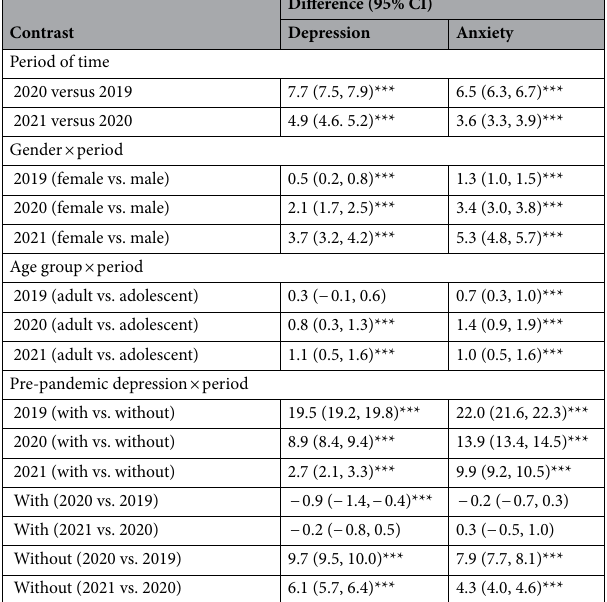
two-way-interactions are presented in Table 3. Females reported higher depression scores compared to males for each pandemic period with increasing differences over time. No differences were found between the age groups in 2019, but with the pandemic’s onset young adults reported increasingly higher depression scores compared to adolescents. Among participants without elevated pre-pandemic depression symptoms (N = 9214) the depression scores increased strongly over time, EMMs in 2019: 7.2 (95% CI: 7.0–7.3), 2020: 17.0 (95% CI: 16.8–17.2), 2021: 23.2 (95% CI: 23.0–23.4). In contrast, for those with elevated pre-pandemic depression (N = 2309) the scores decreased marginally in the first pandemic year and then stayed stable in the second year, EMMs 2019: 26.7 (95% CI: 26.5–26.9), 2020: 25.9 (95% CI: 25.6–26.3), 2021: 25.8 (95% CI: 25.4–26.3). EMMs and 95% CIs for the four-way interaction of time with age group, gender, and pre-pandemic depression status are shown in Fig. 3. Average depression scores of females (both age groups) and male young adults without elevated pre-pandemic depression passed the applied scale-fit 20-point-cut-off in 2021, EMMs for 18–21-year-old males: 22.0 (95% CI: 21.5–22.4), 14–17-year-old females: 24.8 (95% CI: 24.4–25.3), 18–21-year-old females: 24.9 (95% CI: 24.5–25.4). For male adolescents without elevated pre-pandemic depression, the average depression score in 2021 was not significantly different from the 20-point-cut-off, EMM = 20.0 (95% CI: 19.5–20.5). Among participants with elevated pre-pandemic depression symptoms, the depression scores decreased in 2020 compared to 2019 for male adolescents only (diff = − 2.5, 95% CI: − 3.8 to − 1.1), but not for the other three Difference (95% CI) Contrast